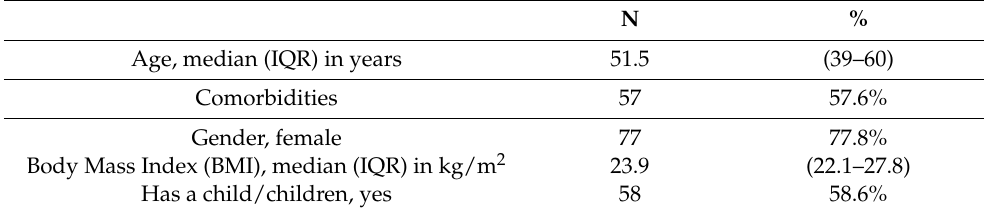
Table 1. Baseline characteristics of participants reporting PLC symptoms, n = 99.